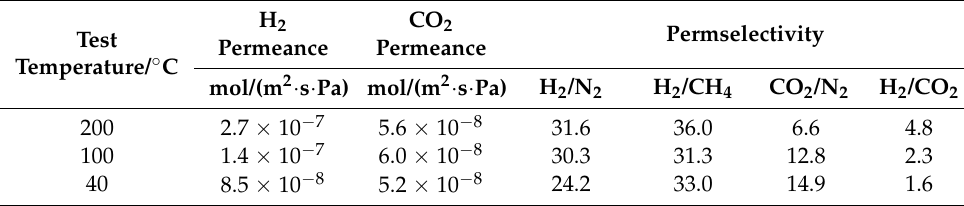
Figure 6. Temperature dependence of gas permeance of ( a ) BTESE-PNEN-0.02 and ( b ) BTESE-PNEN-0.2 mixed matrix membranes. Table 2. Gas permeance and related permselectivity of BTESE-PNEN-0.02 membrane.